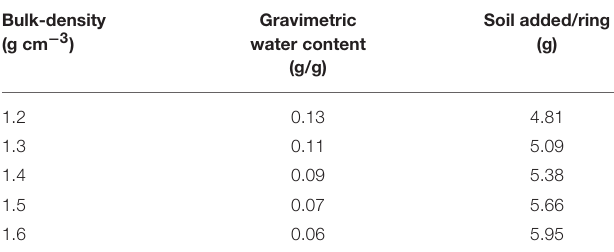
TABLE 1 | The gravimetric water content that results in a moisture content of 40% water filled pores, and the amount of soil per ring/microcosm to pack at a particular